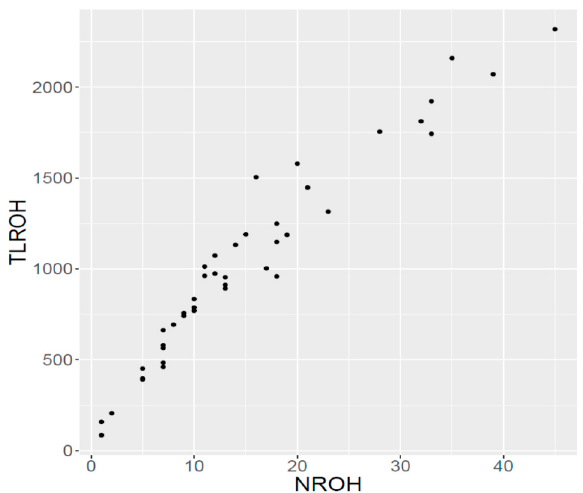
Figure 2. Relationship between total number of ROH (NROH) and total length of the ROH (TLROH, in Mb) per animal, for Ramo Grande bulls. Each dot represents an individual.